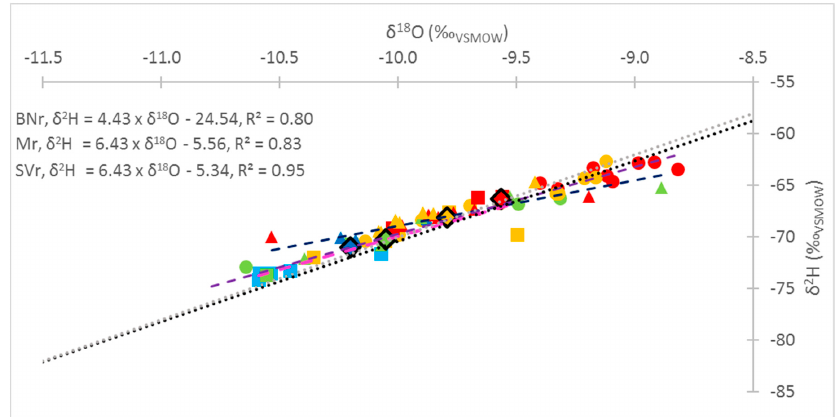
Figure 4. The stable isotope composition of river water from SVr (circle) BNr (square) and Mr (triangle) for winter (blue) spring (green), summer (red) and autumn (orange). The mean values for each season are represented by rhomboids with black contour marks. The dotted black line represents the GMWL and the dotted gray line represents LMWL.